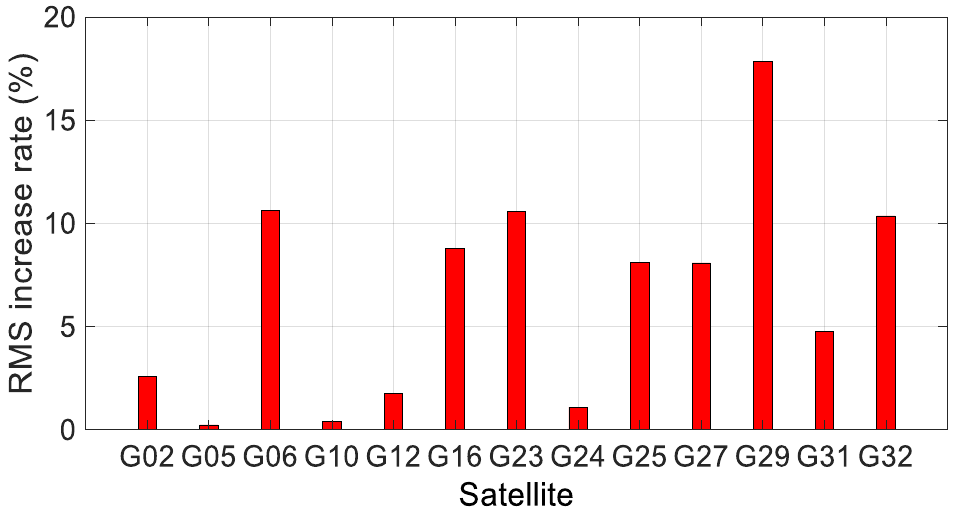
Figure 9. RMS increase rate of all other GPS satellites ’ L1 frequency MP compared with DOY:200.